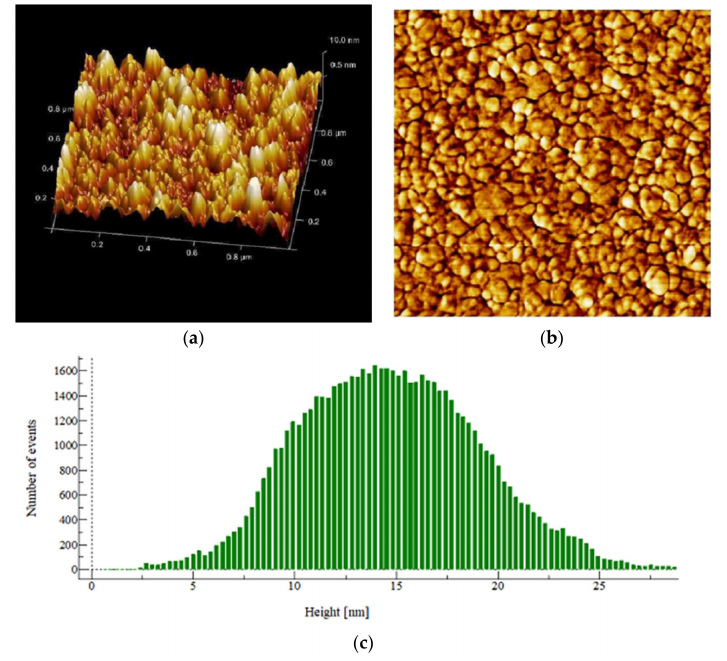
Figure 7. AFM image of S. aureus biofilm surface (treated with standard antimicrobial agent) formed on the polycarbonate membrane filter taken at the 1 × 1 µ m scan area in the tapping mode. ( a ) Height topography 3D and ( b ) The structure and complete surface coverage of the biofilm, and ( c ) Height distribution pattern.